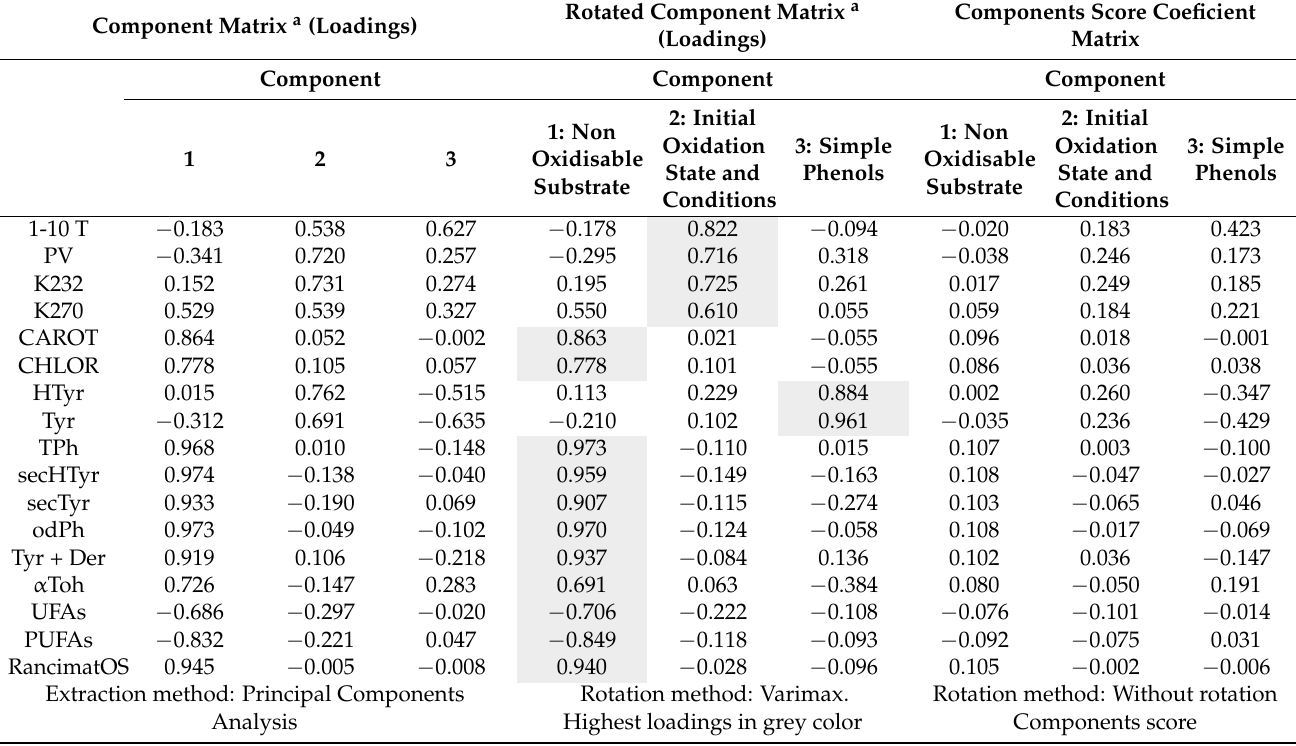
Table 5. Components, loadings and scores of